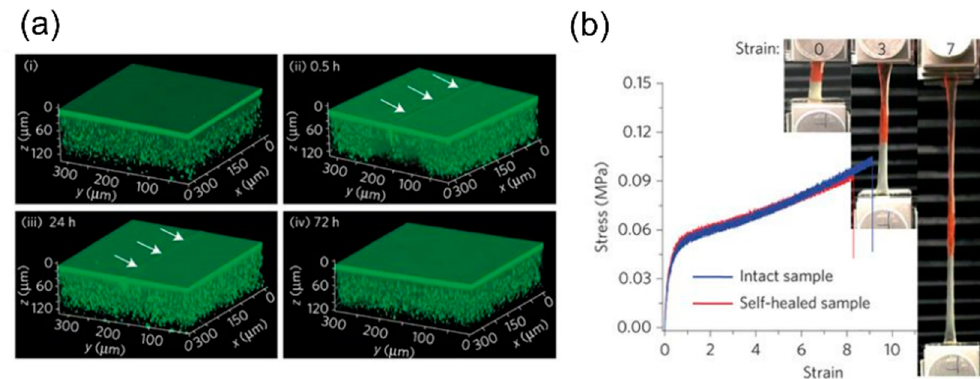
Figure 16. Self-healing of a droplet-embedded polymer–gel matrix. ( a ) Three-dimensional confocal fluorescence images before damage (i) and after damage at 0.5 h (ii), 24 h (iii) and 72 h (iv). Arrows highlight the damaged region. ( b ) Stress–strain curves of the intact and self-healed urea and polydimethylsiloxane (uPDMS) 2 -based sample. Inset images show the self-healed sample composed of two pieces under different strains (one piece was dyed red for contrast). ( a , b ) The liquid surface layer had a thickness of 200 ± 20 µm. The silicone oil loading was 160 wt %. Reprinted by permission from Springer Nature Customer Service Centre GmbH: Springer Nature [65], Copyright 2015.